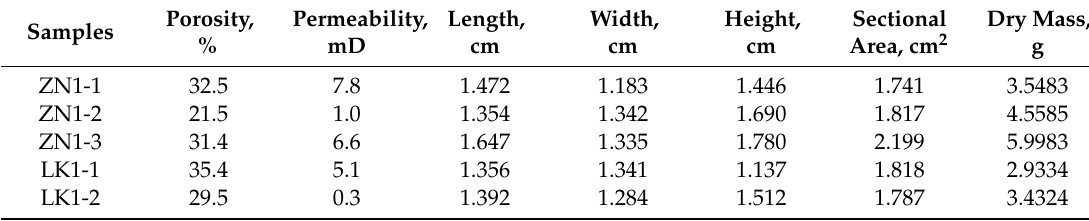
Table 1. Sample physical